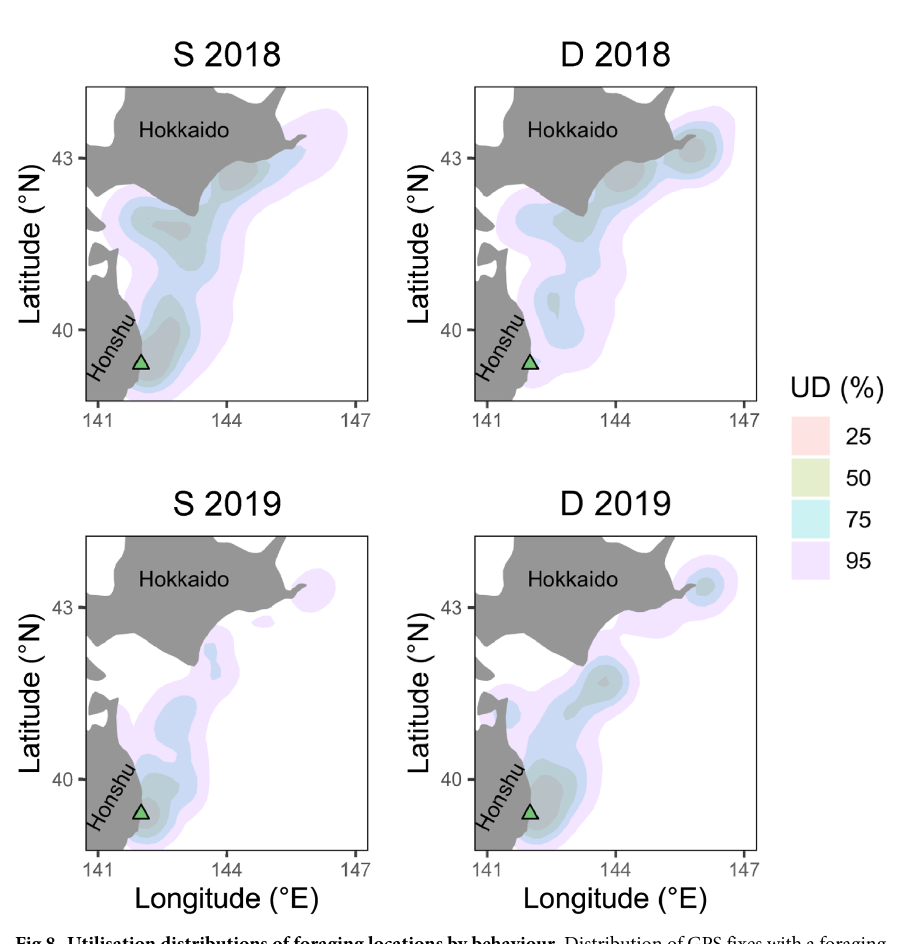
Fig 8. Utilisation distributions of foraging locations by behaviour. Distribution of GPS fixes with a foraging behaviour occurring within 30 seconds. Distributions are split into dives (D) and surface seizing (S). Rows are split by year, 2018 on the top, 2019 on the bottom. The nesting site is indicated by a green